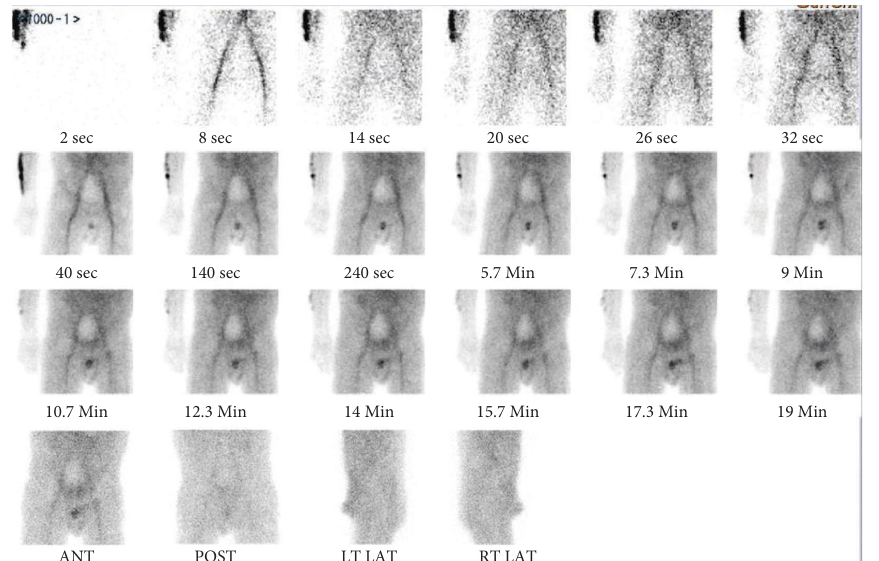
Figure 1: Kidney scintigraphy on day 95 post-transplantation demonstrating a central photopenic region, suggesting absent perfusion of the kidney